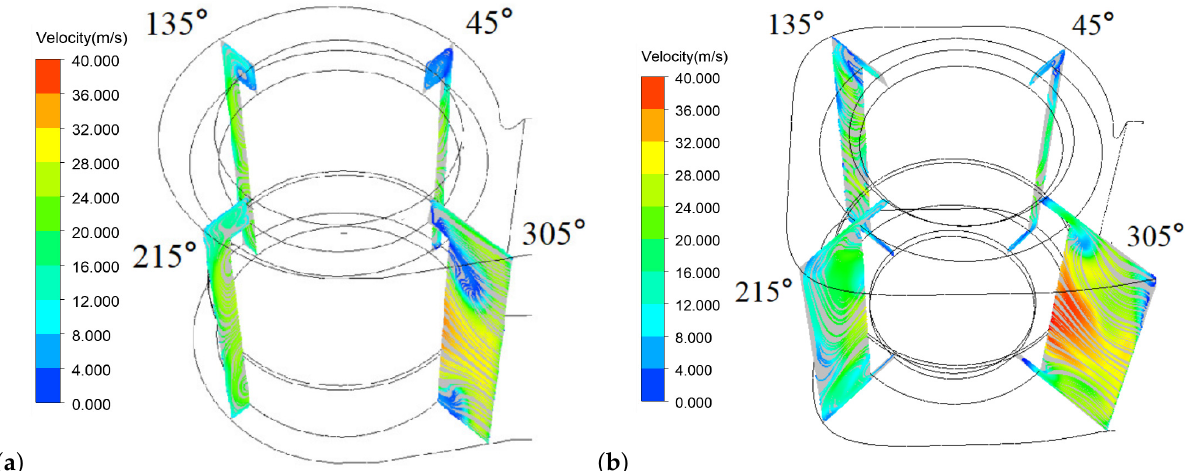
Figure 21. Comparison of impeller outlet radial velocity distribution and streamlines in section A: